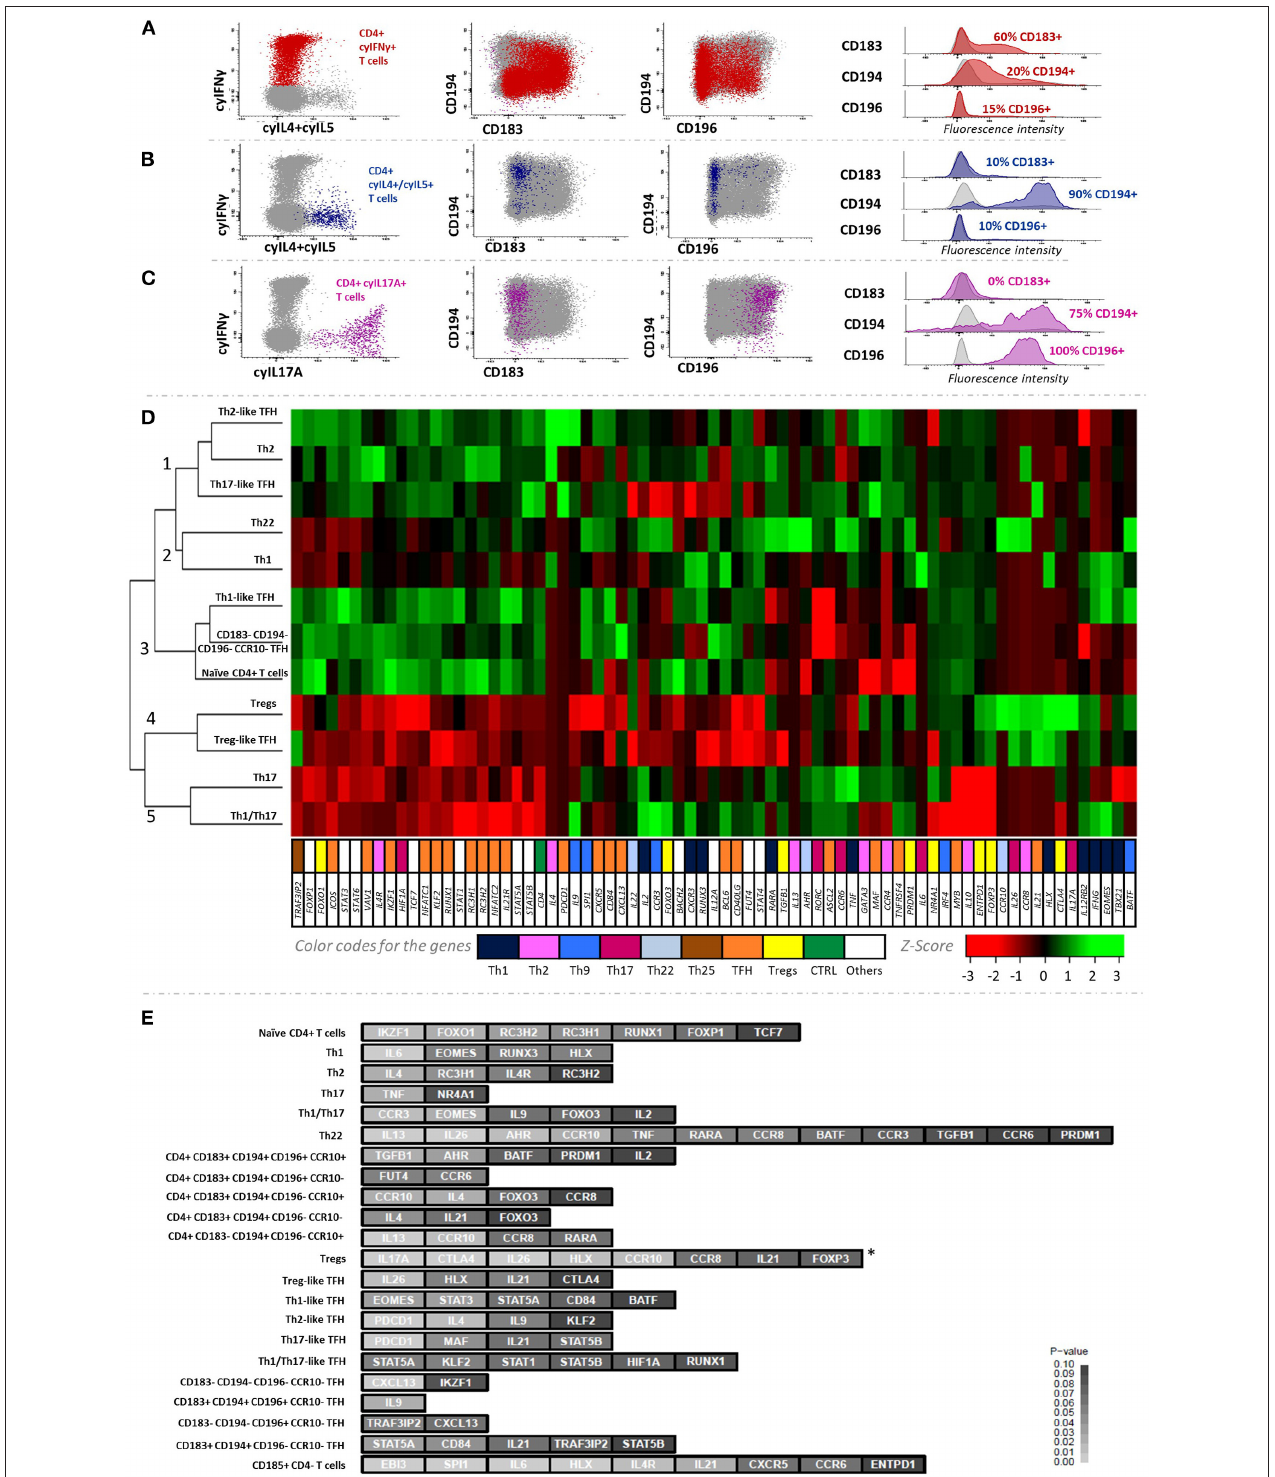
FIGURE 2 | Cytokine secretion profile of the major Th-cell subsets identified in blood and their corresponding gene expression profiles. The association between IFN γ , IL4/IL5, and IL17 production with surface expression of chemokine receptors is depicted in (A–C) , respectively. The cluster heatmap in (D) shows the expression levels of each gene normalized as Z -values corresponding to the 12 main CD4 + T-cell subsets sorted. (E) illustrates the discriminatory ability of different groups of genes among the 22 major CD4 + T-cell subsets. Z -test was used to calculate the Z -scores and one-tailed p -values for all genes studied, based on multivariate comparison of their expression among the different CD4 + T-cell subsets ( p < 0.05; depicted in light gray). *FOXP3 showed significantly ( p = 0.005) higher expression levels in regulatory T-cell subsets (Tregs + Treg-like TFH cells) vs. non-regulatory classical Th cells (Th1 + Th2 + Th17 + Th1/Th17 + Th22).